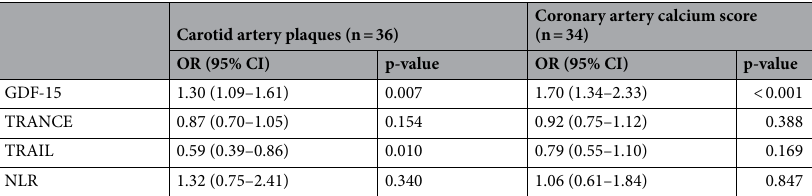
Table 2. Associations between differentially expressed proteins or neutrophil-to-lymphocyte ratio (NLR) and presence of carotid artery plaques and coronary artery calcium score > 100 in patients with psoriasis without cardiovascular disease and statin treatment. For methodological details, see text. GDF-15 growth differentiation factor-15, TRANCE tumor necrosis factor-related activation-induced cytokine, TRAIL tumor necrosis factor-related apoptosis-inducing ligand, OR odds ratio, CI confidence